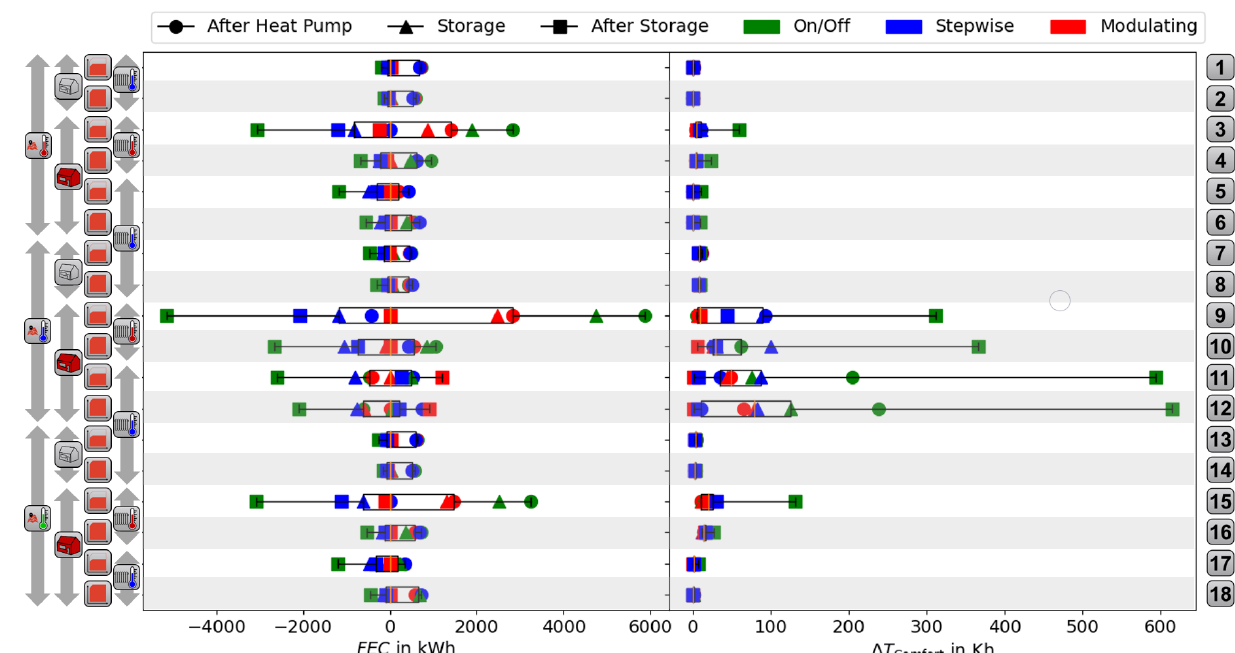
Figure A3. Boxplots for all conducted studies regarding saving potential and thermal